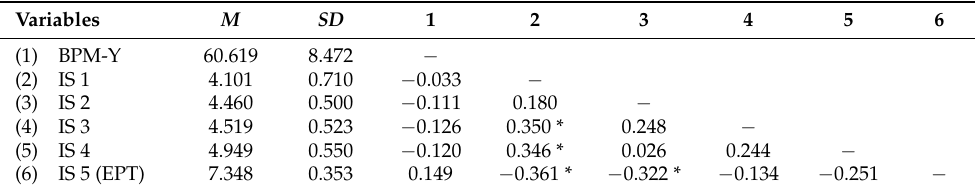
Table 1. Partial